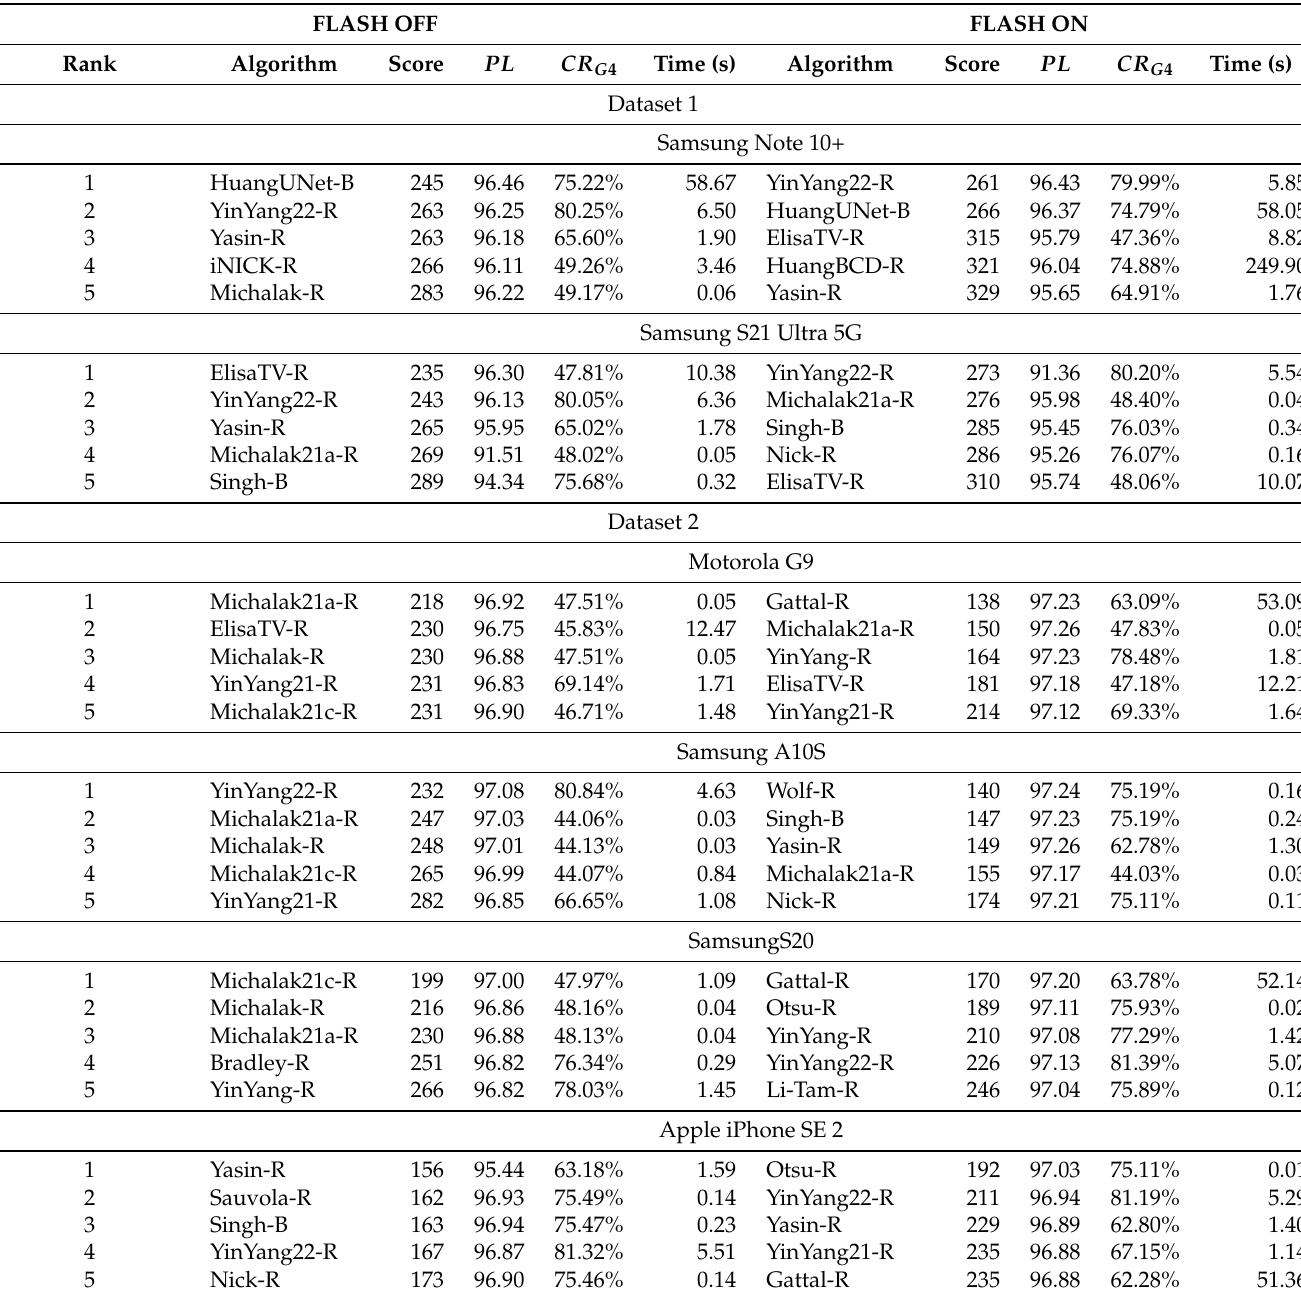
Table 4. Overall results by capturing device sorted according to the ranking summation